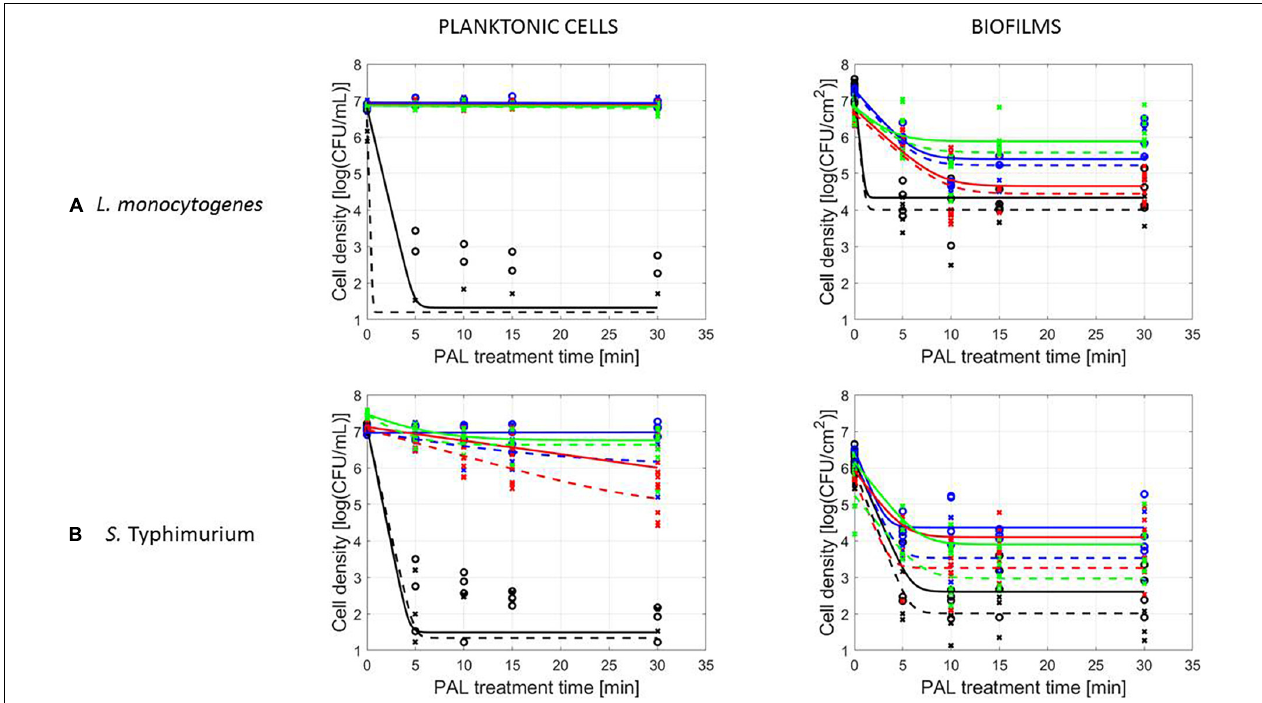
FIGURE 4 | Survival curves of (A) L. monocytogenes or (B) S. Typhimurium planktonic cells and biofilms after treatment with plasma activated liquids of different ages (0, 3, 10, and 30 days). Experimental data (symbols) and global fit (line) of Geeraerd et al. (2000) model: total viable population (o, solid line) and uninjured viable population (x, dashed